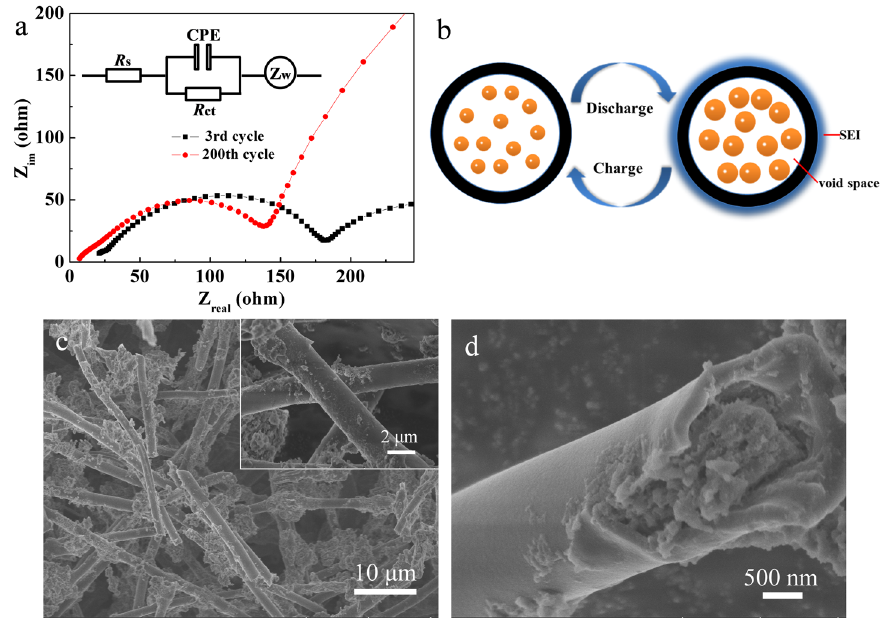
Figure 6: ( a ) EIS test of Si@CNF - 15 wt% at the third and 200th cycles ( the inset is equivalent circuit model ) , ( b ) structural change during cycling process for Si@CNF electrode and ( c and d ) SEM images of surface morphology after 200